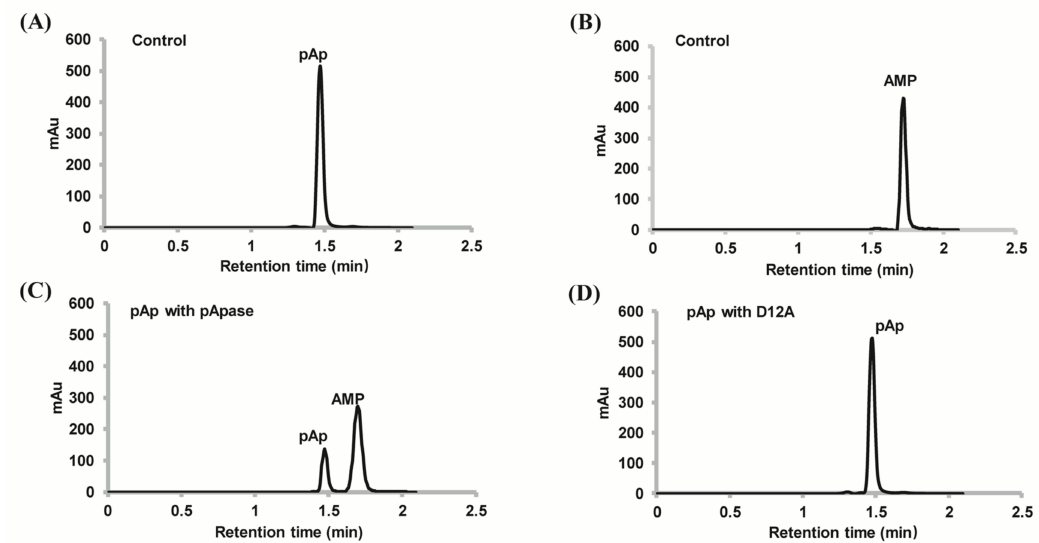
Figure 2. pApase degrades pAp into 5 (cid:48) AMP and PPi. Standard elution curves of pAp ( A ) and AMP ( B ). Hydrolysis of pAp by wt pApase ( C ) and ion binding deficient mutant D12A ( D ). Additionally, 0.2 mM pAp was incubated with 3.75 nM of PyapApase or its mutant D12A at 70 ◦ C for 5 min in reaction buffer consisting of 20 mM Tris-HCl pH 8.0, 50 mM NaCl, and 0.5 mM Mn 2+